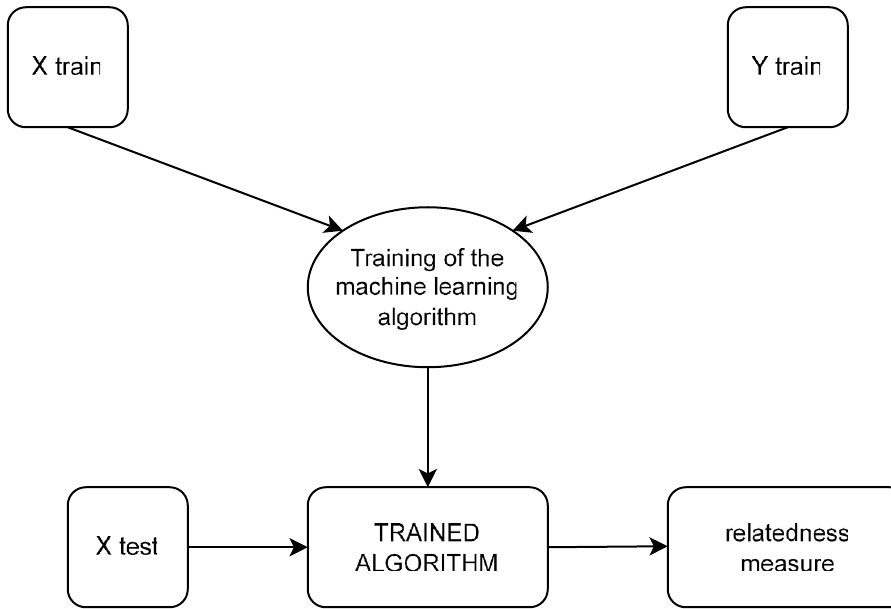
Figure 9. Schematic diagram with the functioning of machine learning algorithms to assess the relatedness between countries and a target product. During the training phase the model receives an X train matrix with the training samples (countries) and their features (products) for the years from 1996 to 2008; they are compared with the Y train vector that contains the corresponding possible exports the target product in 2001–2013 (that is, a binary label for each sample). Once the model is trained, it can receive in input new data (that is, an export basket) and will provide the probability that the label (the possible export of the target product)) is 1. This progression score is our assessment of the